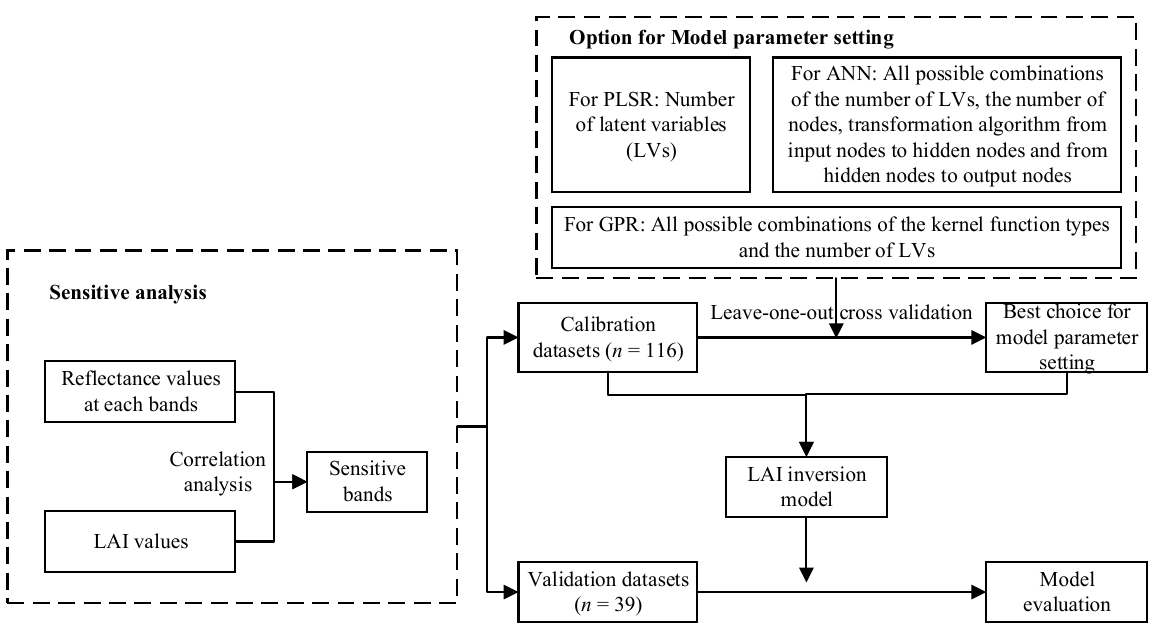
Figure 2. Flow chart of the LAI prediction models design based on PLSR, ANN and GPR methods.